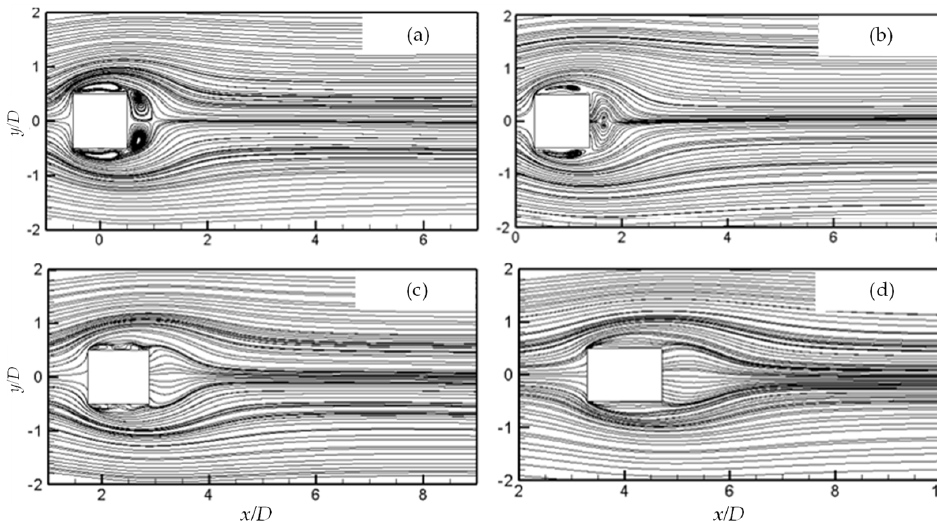
Figure 11. Time-averaged streamlines for different yaw angles viewed on the ( x , y ) plane at z = 4 D . ( a ) α = 0°; ( b ) α = 15°; ( c ) α = 30°; ( d ) α = 45°. ( a ) α = 0 ◦ ; ( b ) α = 15 ◦ ; ( c ) α = 30 ◦ ; ( d ) α = 45 ◦